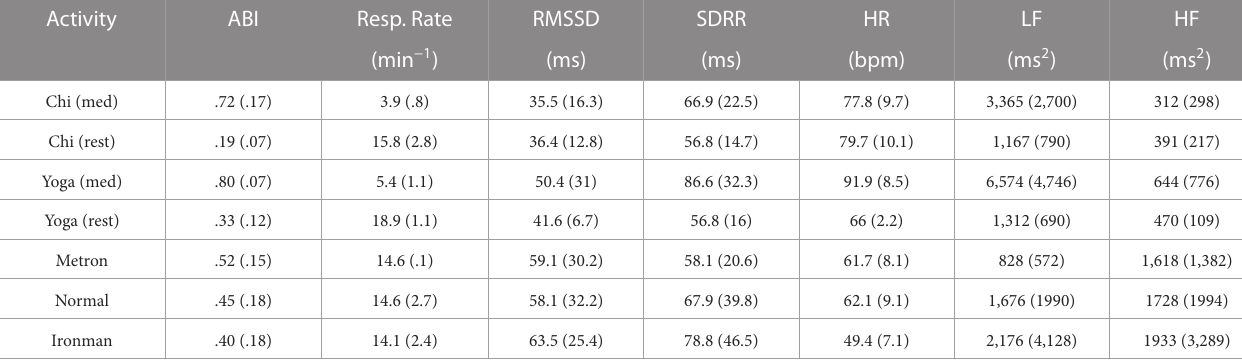
TABLE2 Mean(standarddeviation)computedforthe7cohorts,fordifferentmetrics.